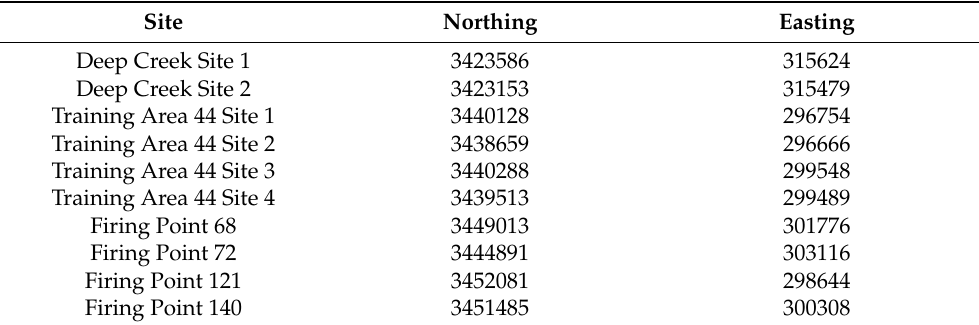
Table A1. UTM coordinates of all study sites at Camp Shelby Joint Forces Training Center, Missis- sippi,